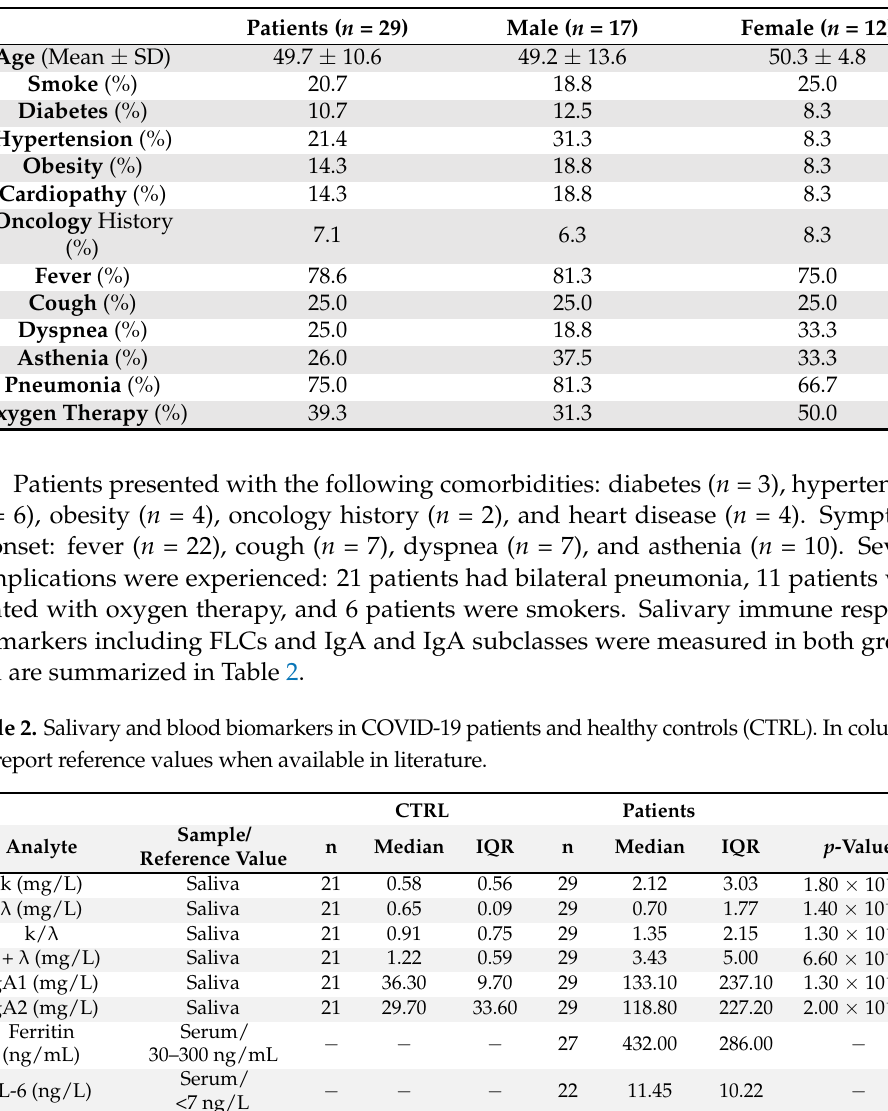
Table 1. Clinical and demographic characteristics of the enrolled patients.